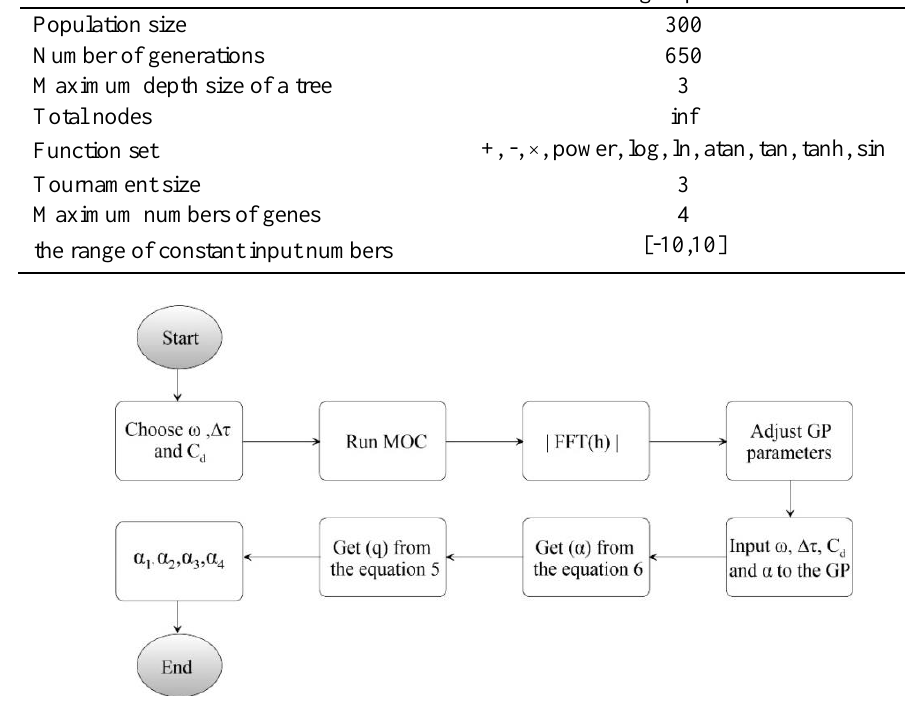
Fig 7. flowchart of the 𝛂 value